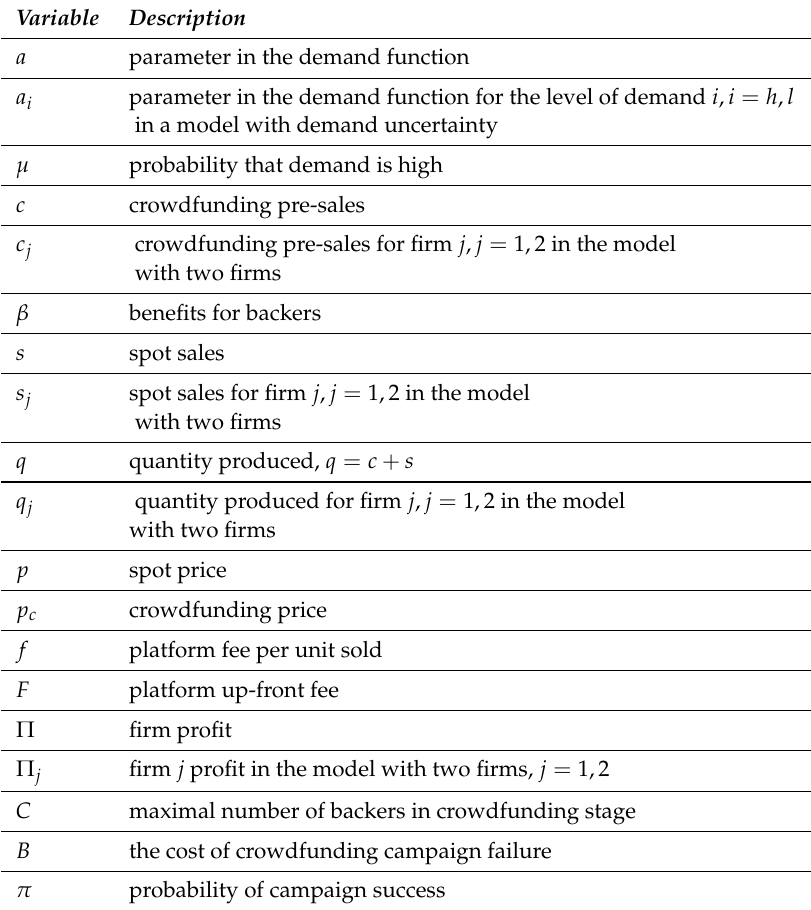
Table 1. Notations